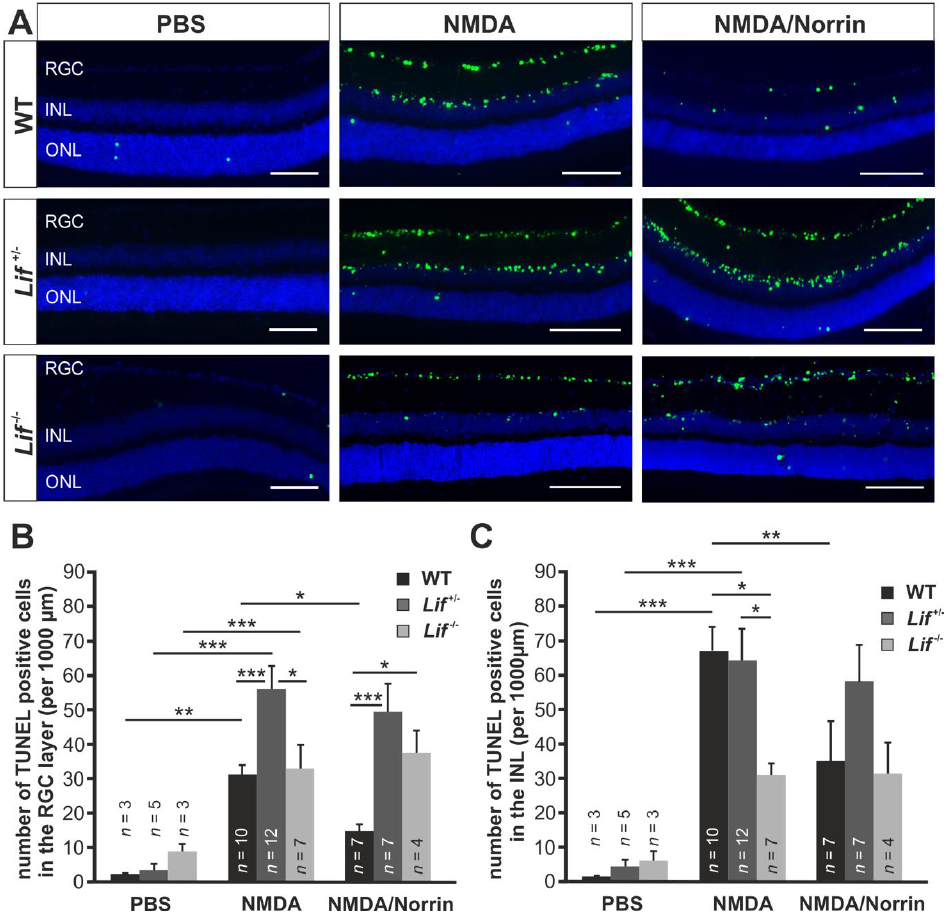
Figure 3. Norrin mediates its neuroprotective effect via an induction of Lif. ( A ) Representative TUNEL staining (green) of retinae from heterozygous ( Lif +/ − ) and homozygous, Lif-deficient mice ( Lif − / − ), as well as wild-type (WT) littermates 24 h after intravitreal injection of 3 µL PBS, 3 µL NMDA [10mM] or 3 µL NMDA [10mM] with Norrin [5 ng/µL]. RGC: retinal ganglion cell layer; INL: inner nuclear layer; ONL: outer nuclear layer; blue, DAPI staining; scale bars: 50 µm. ( B , C ). The number of TUNEL positive cells in the RGC ( B ) and INL ( C ) of all genotypes was quantified and plotted as the number of TUNEL positive cells per 1000 µm retinal length. * p < 0.05; ** p < 0.01; *** p < 0.001.